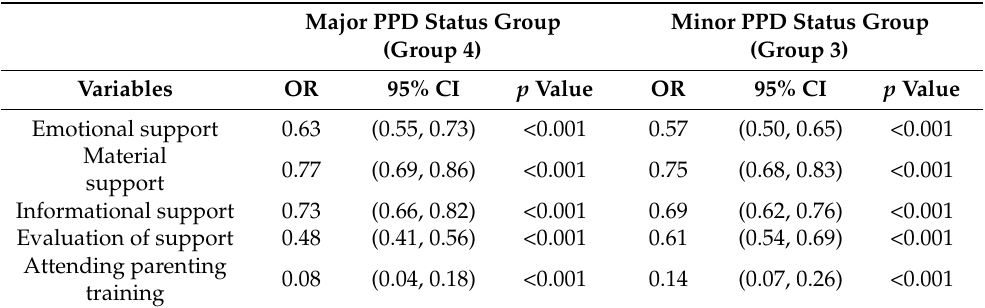
Table 5. Multinomial logistic regression predicting factors associated with PPD status trajectory membership. Major PPD Status